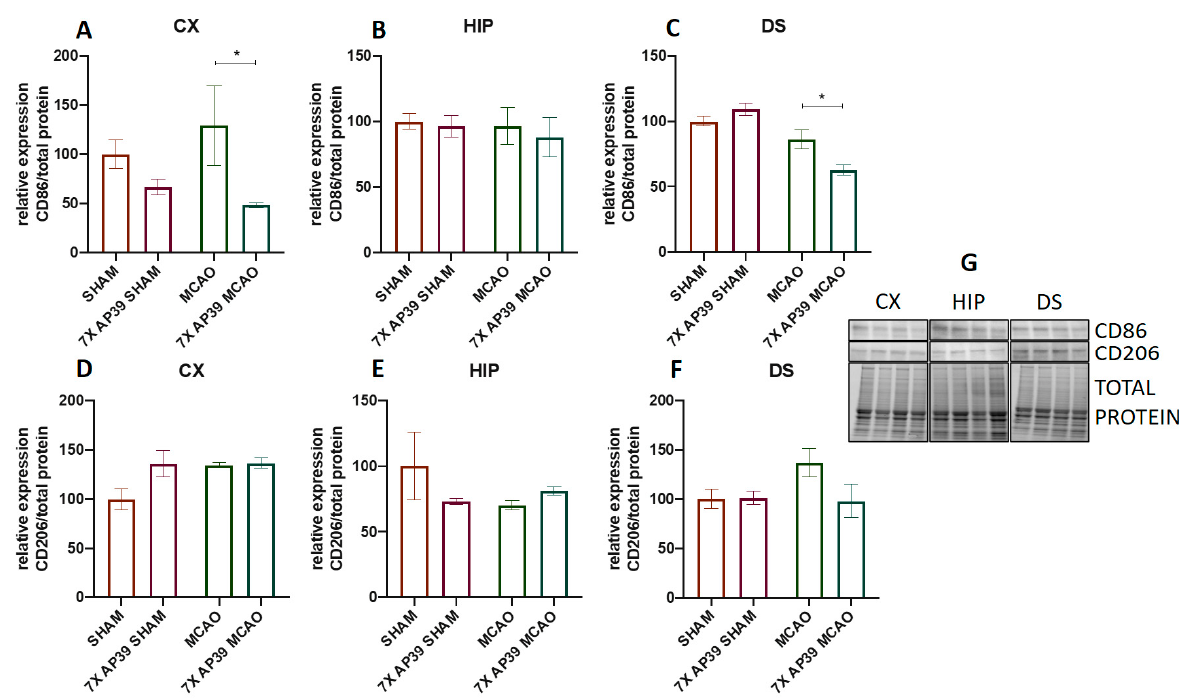
Figure 6. The effect of MCAO and AP39 on the protein expression of ( A – C ) CD86 and ( D – F ) CD206 in the ipsilateral brain structures ( A , D ) of the frontal cortex (CX), ( B , E ) the hippocampus (HIP) and ( C , F ) the dorsal striatum (DS). ( G ) Immunoblots representative for the CX, HIP, and DS for CD86 and CD206, together with the total protein amount visualized by the stain-free technique. The order of the samples is the same as in the graphs. n = 6, one-way ANOVA, followed by Sidak’s correction for post hoc comparisons; * p < 0.05 vs. MCAO or SHAM. Data are presented as the mean ± SEM.